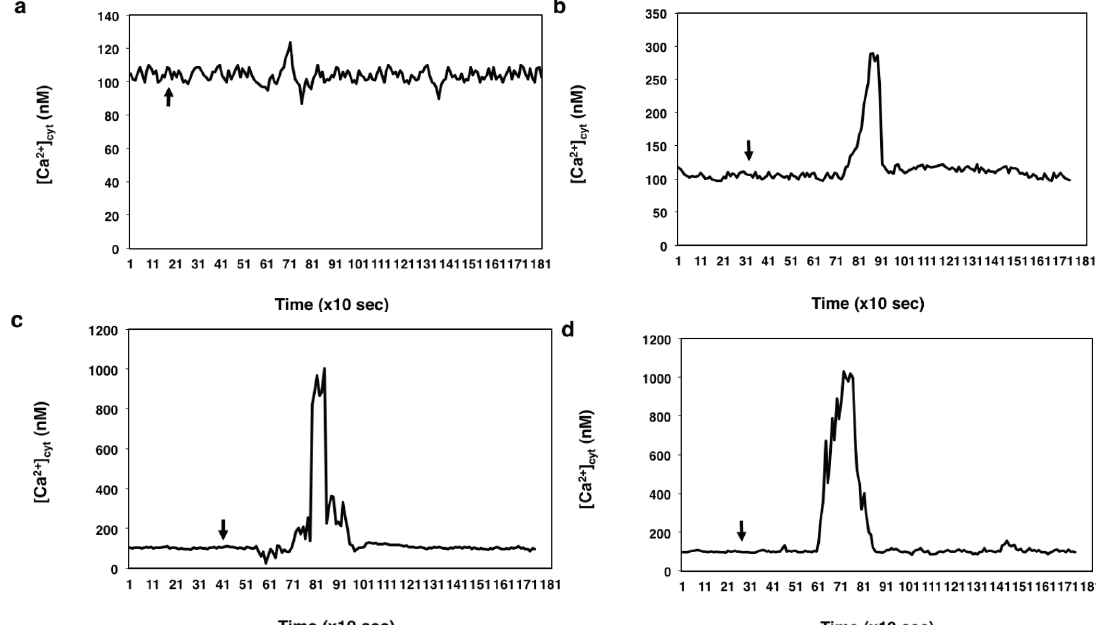
Figure 6. The effect of thapsigargin on [Ca 2+ ] cyt measured in unfertilized egg cells incubated in calcium-free IVF medium. Thapsigargin was added to unfertilized eggs at: 0.1 μ M ( a ), 1 μ M ( b ), 10 μ M ( c ) and at 50 μ M ( d ). The arrows designate the times of the addition of the